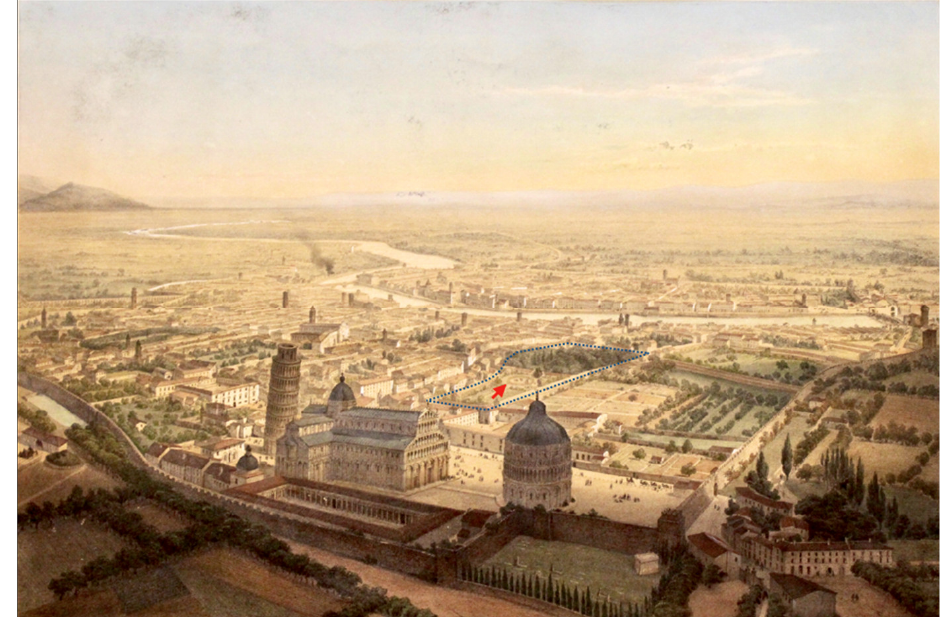
Figure 1. Guesdon’s drawing of Pisa, circa 1849. The dotted blue line follows the Botanic Garden perimeter; the red arrow points at the circular enclosure where the giraffe was kept along with two animals. The northern side (towards the Leaning Tower) is the “Orto Nuovo”, annexed to the Botanic garden in 1841; the southern side (towards the river) is the original late-XVI century garden ground. In the drawing the Orto Nuovo appears as an open space, with few trees along its edges, while a luxuriant tree cover fills the old part. A line of buildings clearly separates the two sectors (see also Figures 2 and 3).